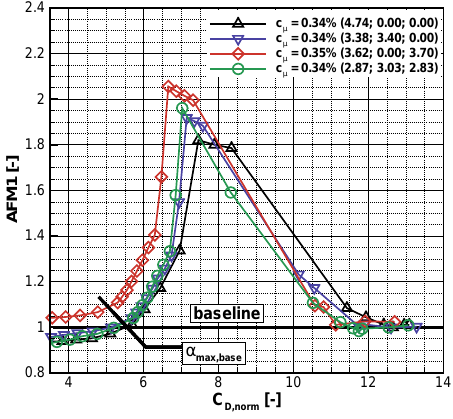
Figure 26. First aerodynamic figure of merit for a constant momentum